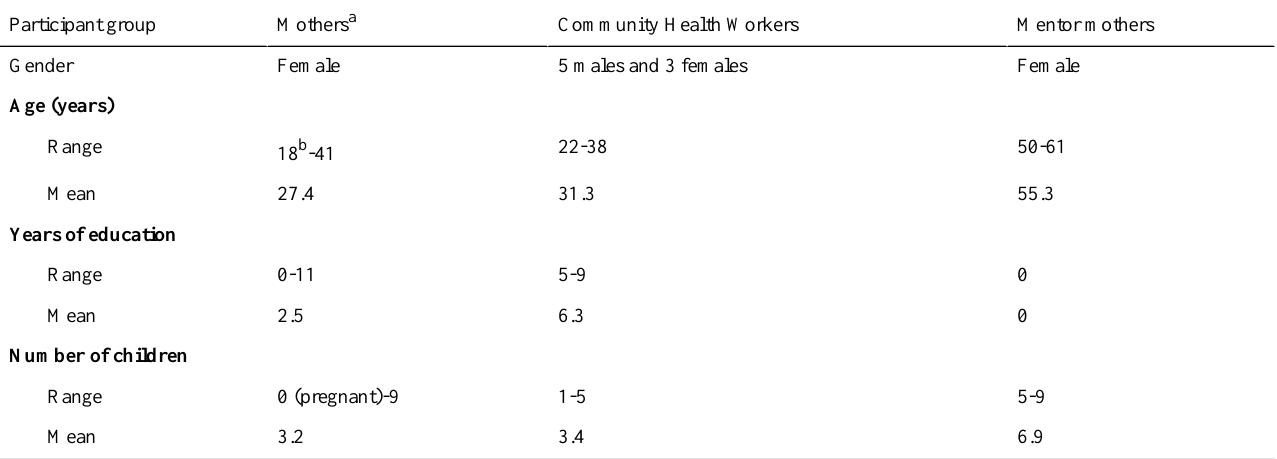
Table 5. Sociodemographic characteristics of participant groups.